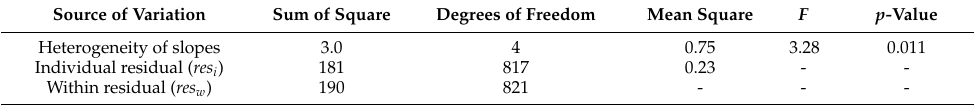
Table 12. Computation heterogeneity of slopes for cutting facilities based on sand casting.